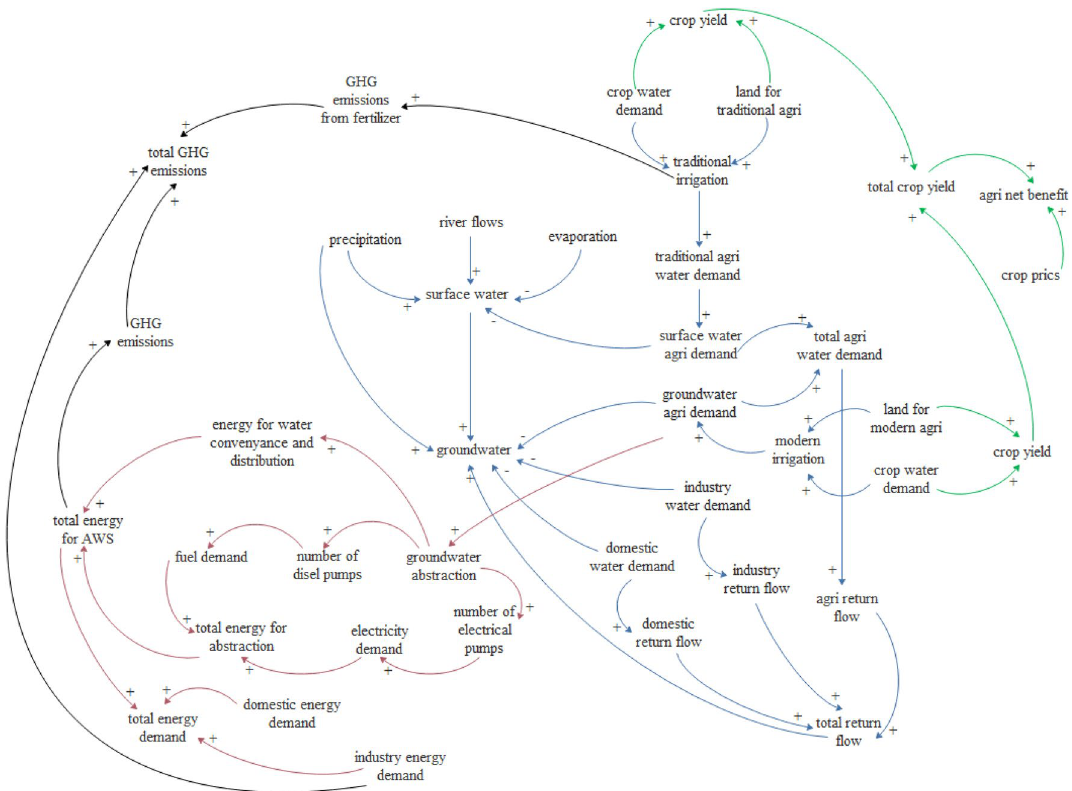
Figure 8. Interrelationships between the water-energy-food components of agricultural systems.